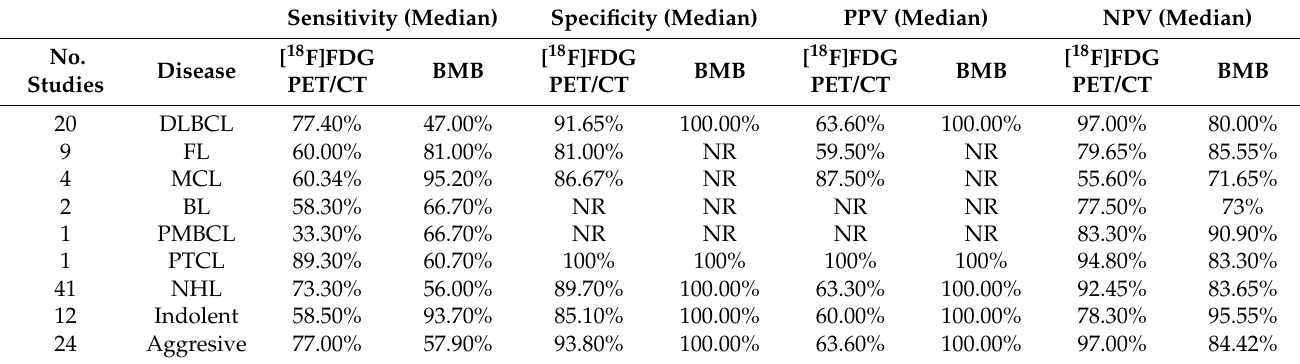
Table 5. Diagnostic performance of [ 18 F]FDG PET/CT and BMB in determining BMI in NHL cases and subtypes of NHL lymphoma